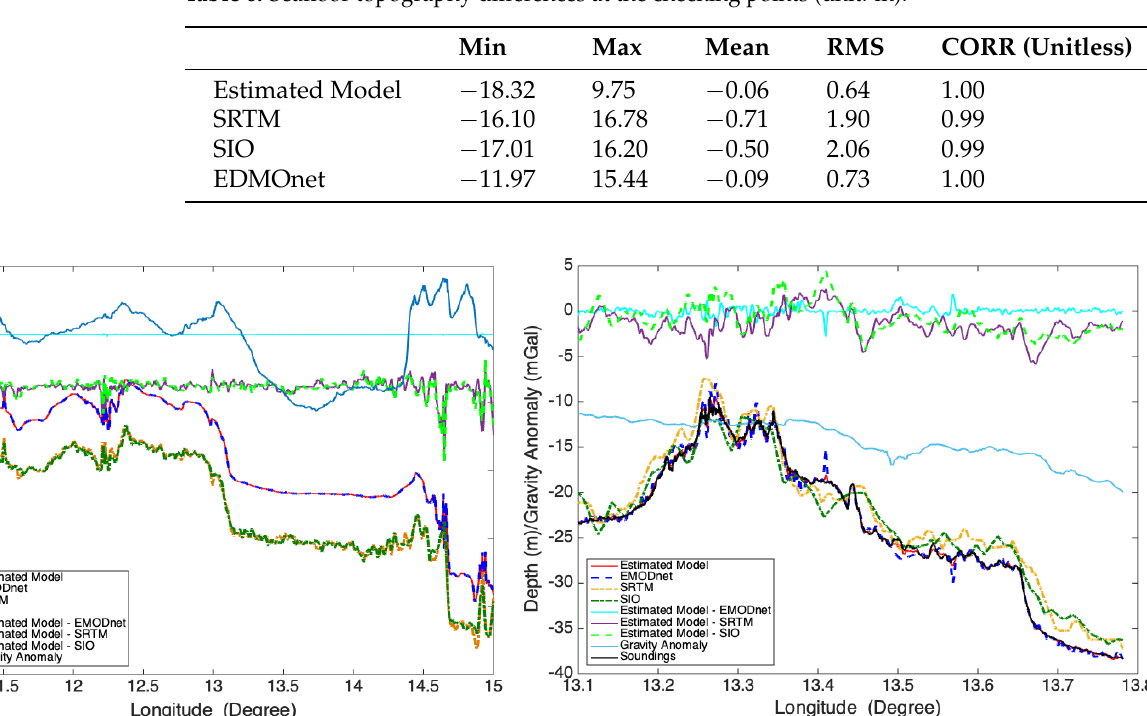
Table 6. Seafloor topography differences at the checking points (unit: m).